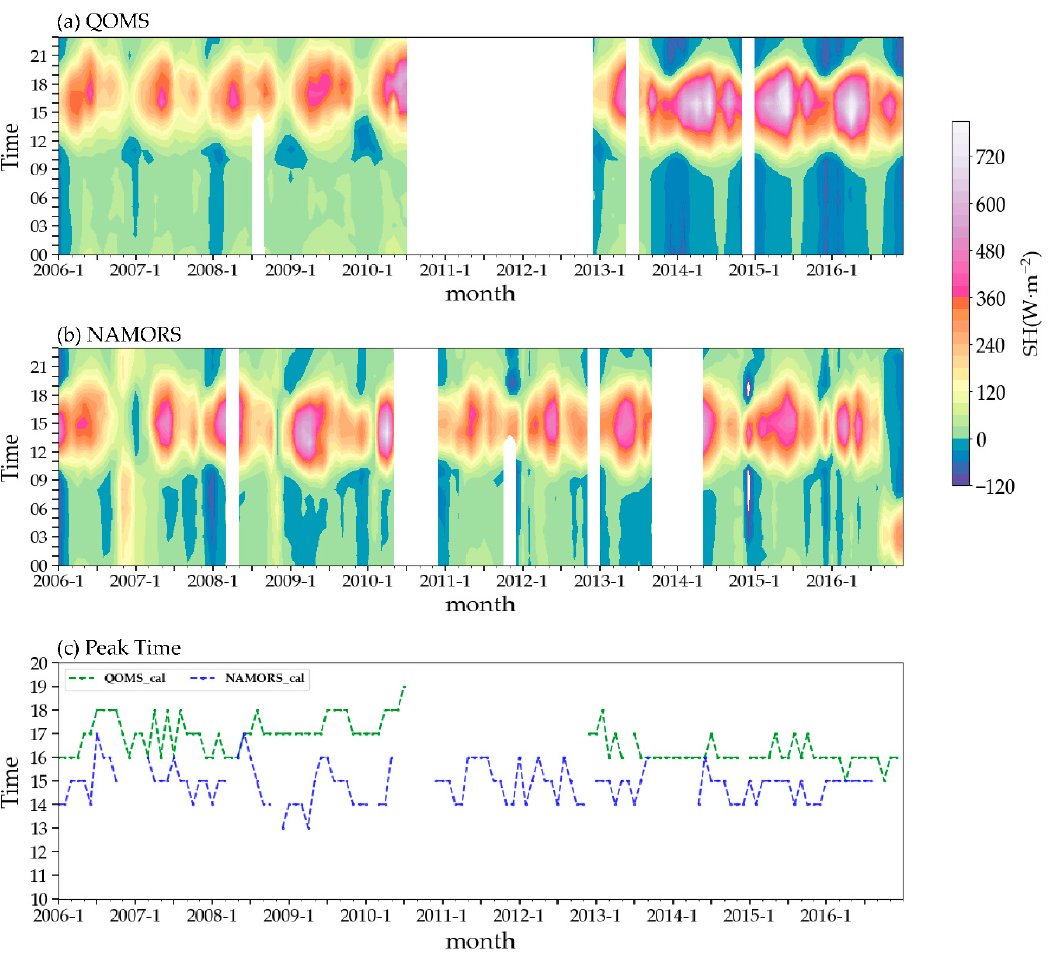
Figure 7. Monthly mean of the diurnal variation in calculated SH (shaded, W m − 2 ) at ( a ) QOMS and ( b ) NAMORS during the period 2006–2016. The curve lines in ( c ) represent the peak timing (hour) of monthly SH diurnal variation at each station, respectively.